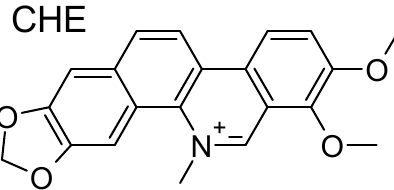
Figure 1. Figure 1. Molecular formula of chelerythrine (CHE). Note the positive charge center on the nitrogen atom.